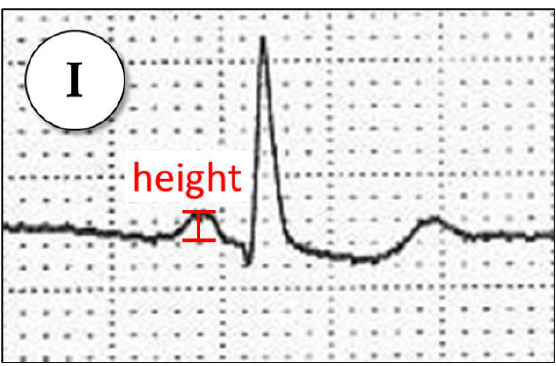
Figure A6. P-wave voltage in lead I.